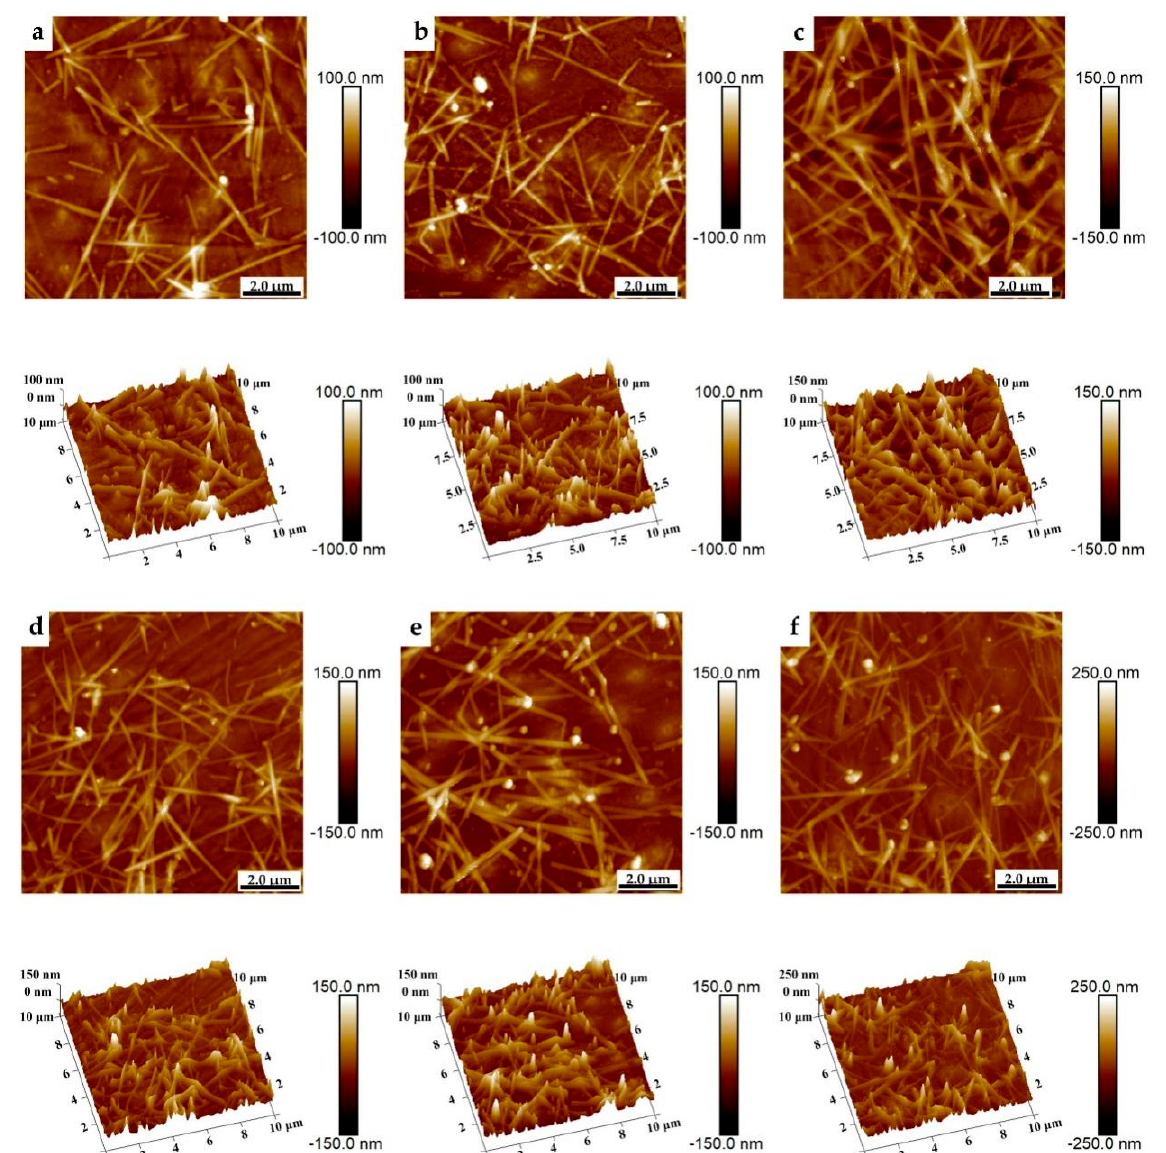
Figure 5. 2D and 3D AFM images of the AgNWs patterns with the printed layers of 8 ( a ), 10 ( b ), 12 ( c ), 14 ( d ),16 ( e ), and 18 ( f ).